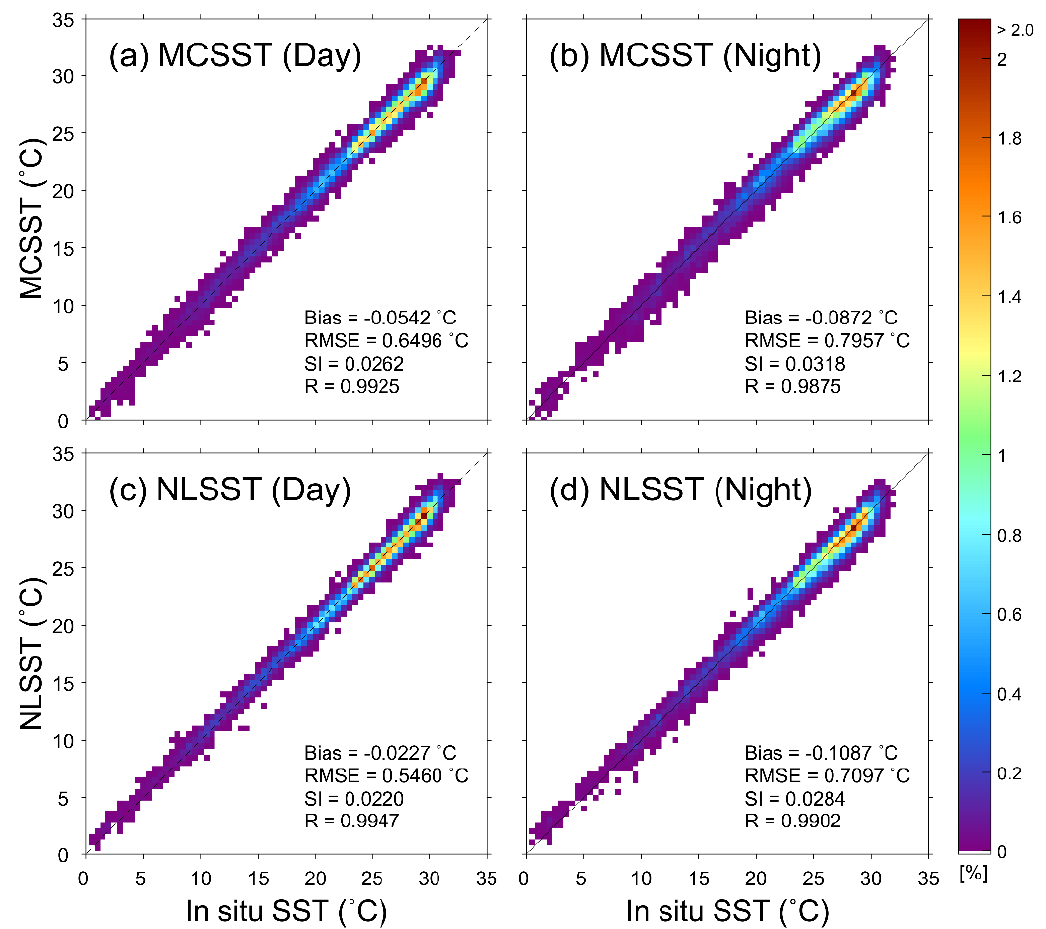
Figure 11. Comparison between MCSSTs and in situ temperatures during the ( a ) daytime and ( b ) nighttime and between NLSSTs and in situ temperatures during the ( c ) daytime and ( d ) nighttime for the period from April 2014 to March 2015, where the color represents the percentage of the data to the total number of matchup points in a bin of 0.5 ◦ C × 0.5 ◦ C. Bias, root mean square error (RMSE), scatter index (SI), and correlation coefficient (R) are given in each plot.